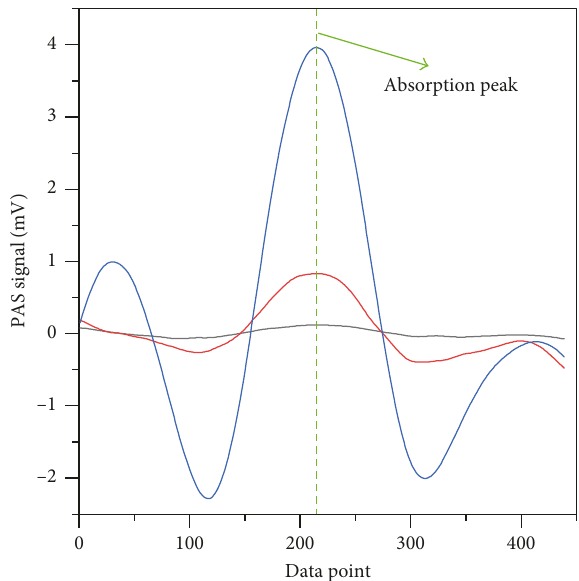
Figure 6: C 2 H 6 PAS signals obtained with 100ppmv, 1000ppmv, and 5000ppmv C 2 H 6 samples, respectively. The dotted line posi- tion corresponds to the absorption peak of Figure